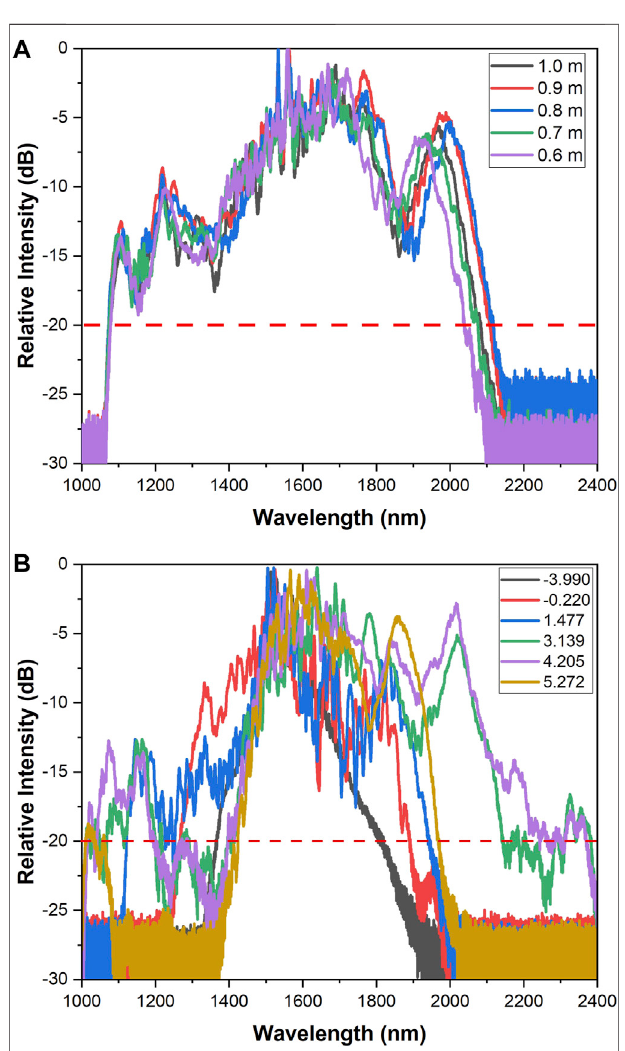
FIGURE 3 | (A) SC spectra in the HNLF with D = 3.139 ps/nm/km by changing the HNLF length. (B) SC spectra in a 0.8-m-long HNLF with respect to different